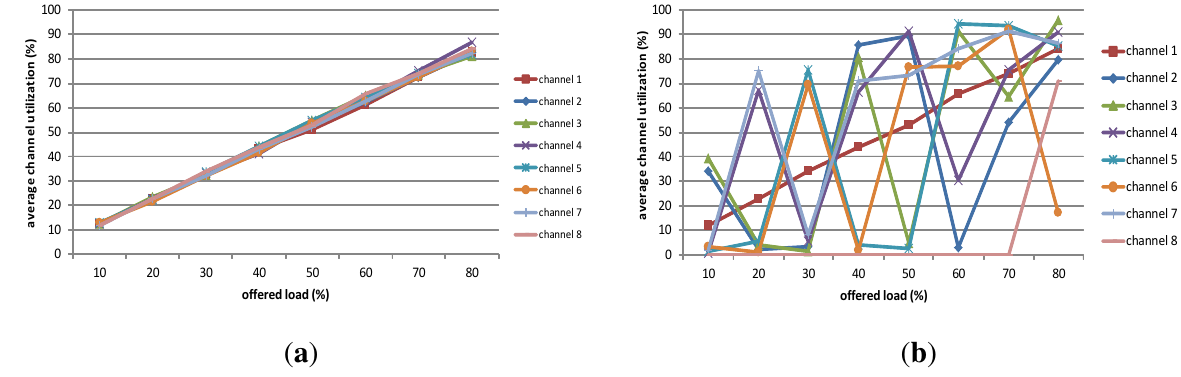
Figure 5. Average channel utilization. ( a ) Average Channel Utilization without energy-saving; ( b ) Average Channel Utilization with energy-saving.